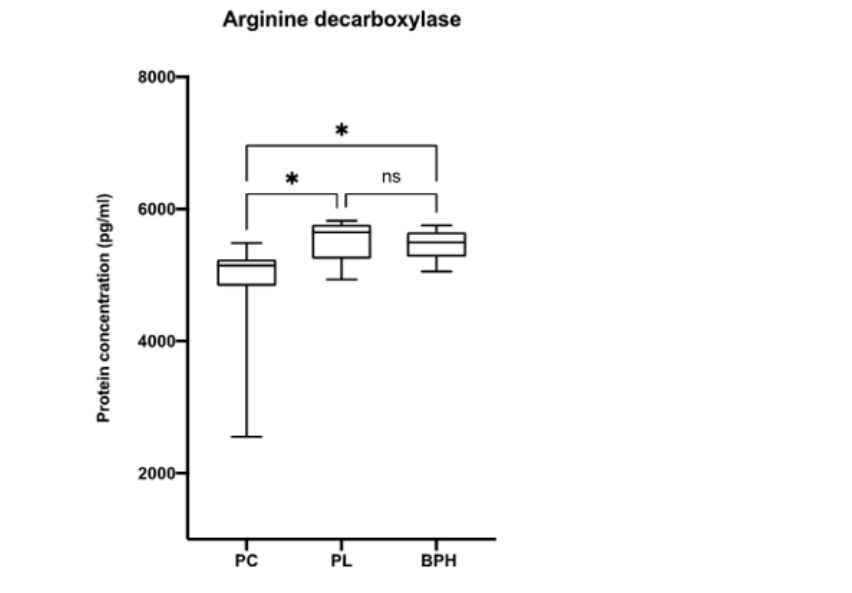
Figure 7. Arginine decarboxylase (ADC) quantification by ELISA. The concentration of ADC was measured in the plasma of patients from each group. Data are expressed as mean ± SD with reference to the control (mean ± SD; n = 170) (* p ≤